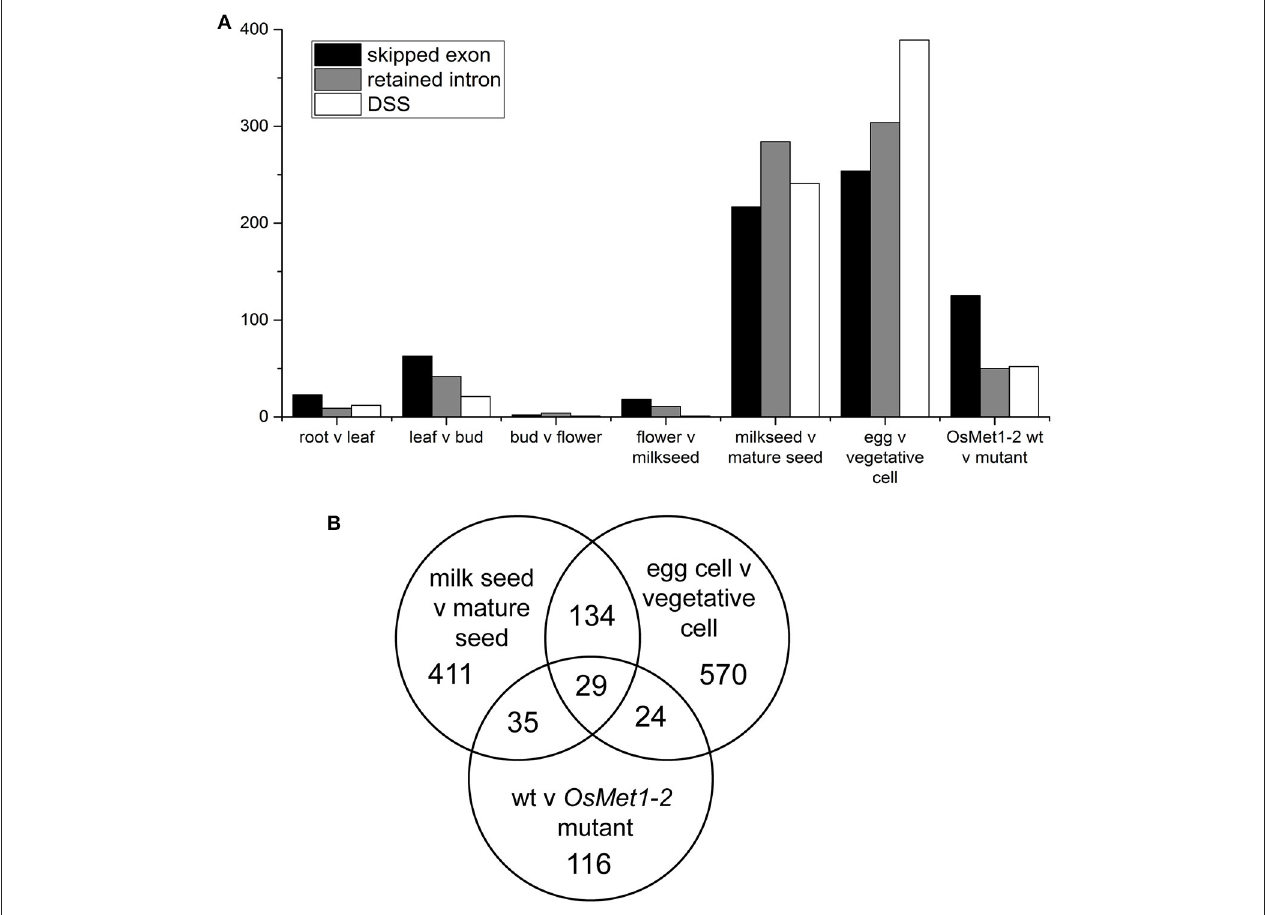
FIGURE 1 | (A) Alternative splicing events identified in comparisons of tissues, gametes (egg and vegetative cells), and seedlings of lethal methylase mutant OsMet1-2 . Numbers represent statistically significant alternative splicing events called by rMATS at p < 0.005 and FDR of < 0.05. (B) Venn diagram of predicted splicing events shared by and unique to the three datasets with significant